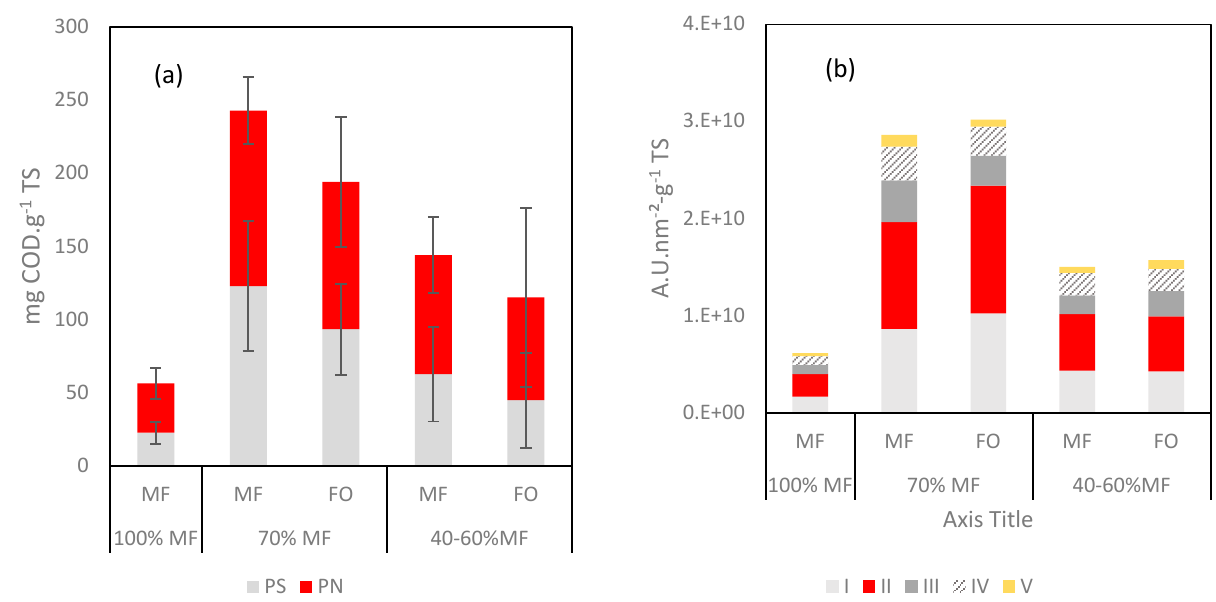
Figure 8. ( a ) Protein (PN) and polysaccharide (PS) contents and ( b ) 3DEEM volume of fluorescence normalized for the fouling layer reported as function of the TS.